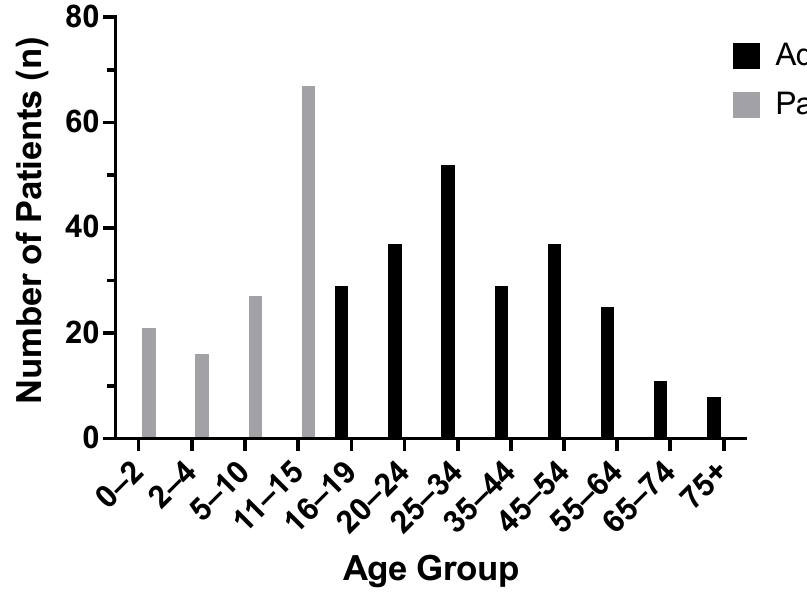
Figure 1. Age of patients presenting to the combined Manchester adult and paediatric burn centres between 2010–2019 (inclusive).